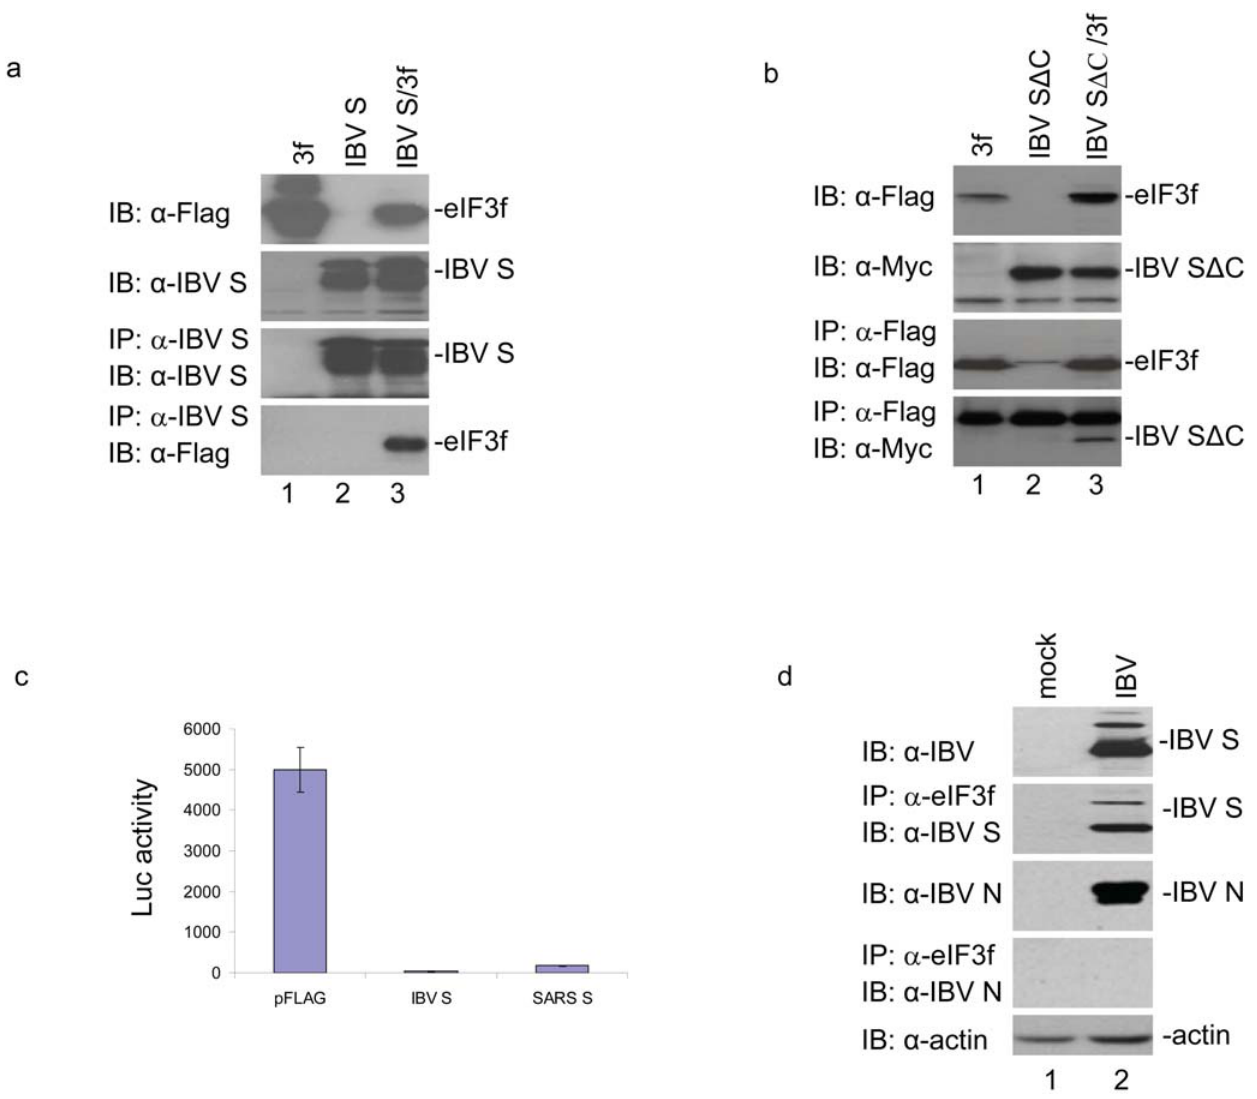
Figure 4. Interaction of the IBV S protein with eIF3f and inhibition of protein synthesis. a. Confirmation of the interaction between the Flag- tagged eIF3f and the full-length IBV S protein by co-immunoprecipitation. HeLa cells expressing the Flag-tagged eIF3f (lane 1), IBV S (lane 2) and eIF3f + IBV S (lane 3) by using the vaccinia/T7 expression system were harvested at 24 hours post-transfection and lysed. The total cell lysates were either detected directly by Western blot with anti-Flag (top panel) and anti-IBV S (second panel) antibodies or immunoprecipitated with anti-IBV S antibodies. The precipitates were analyzed by Western blot with anti-IBV S (third panel) and anti-Flag (bottom panel) antibodies. b. Interaction of the Flag-tagged eIF3f with the N-terminal region of the IBV S protein (IBV S D C). HeLa cells expressing the Flag-tagged eIF3f (lane 1), the Myc-tagged IBV S D C (lane 2) and eIF3f + IBV S D C (lane 3), were harvested at 24 hours post-transfection and lysed. The total cells lysates were either detected directly by Western blot with anti-Flag (top panel) and anti-Myc (second panel) antibodies, or immunoprecipitated with anti-Flag antibody. The precipitates were analyzed by Western blot with anti-Flag (third panel) or anti-Myc (bottom panel) antibodies. c. Inhibition of luciferase activity by IBV and SARS- CoV S protein. HeLa cells expressing luciferase, luciferase + IBV S and luciferase + SARS-CoV S by using the vaccinia/T7 system were harvested at 24 hours post-transfection, lysed, and the luciferase activities in the total cell lysates were measured. d. Co-immunoprecipitation analysis of the interaction between IBV S protein and the endogenous eIF3f in IBV-infected Vero cells. Mock- and IBV-infected Vero cells were harvested at 24 hours post-infection and lysed. The total cell lysates were either detected directly by Western blot with anti-IBV S (top panel), anti-IBV N (third panel) and anti-actin (bottom panel) antibodies, respectively, or immunoprecipitated with anti-eIF3f antibody. The precipitates were analyzed by Western blot with anti-IBV S (second panel) or N (fourth panel) antibodies.